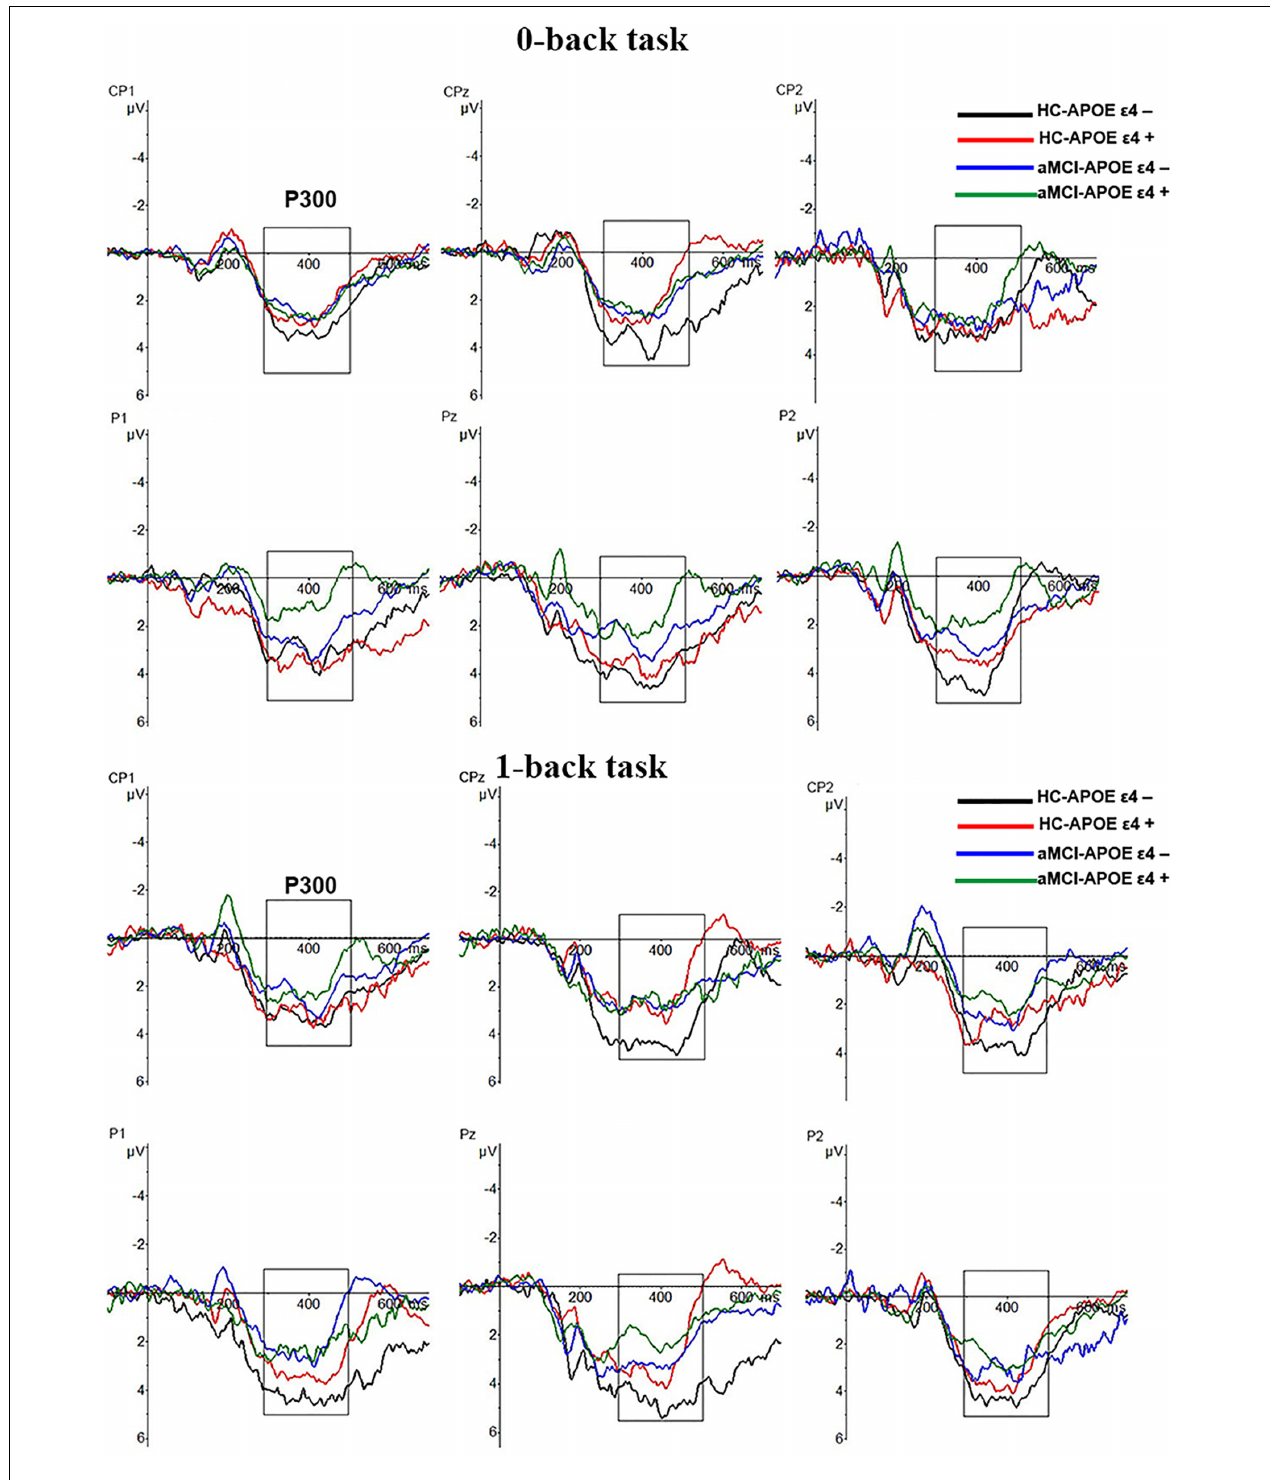
FIGURE 2 | Grand-average event-related potential (ERP) waveforms of the 0-back and 1-back task for HC-APOE ε 4–, HC-APOE ε 4+, aMCI-APOE ε 4–, and aMCI-APOE ε 4+ participants. Grand-average ERP at the central–parietal (CP1, CPz, and CP2) and parietal (P1, Pz, and P2) electrodes for HC-APOE ε 4– participants in 0- and 1-back task (black line), HC-APOE ε 4+ participants in 0- and 1-back task (red line) and aMCI-APOE ε 4– participants in 0- and 1-back task (blue line), aMCI-APOE ε 4+ participants in 0- and 1-back task (green line). Dashed squares on each graph represent the time windows used for analyses of the P300 component. Abbreviations: aMCI, amnestic mild cognitive impairment; APOE, apolipoprotein E; HC, healthy controls.